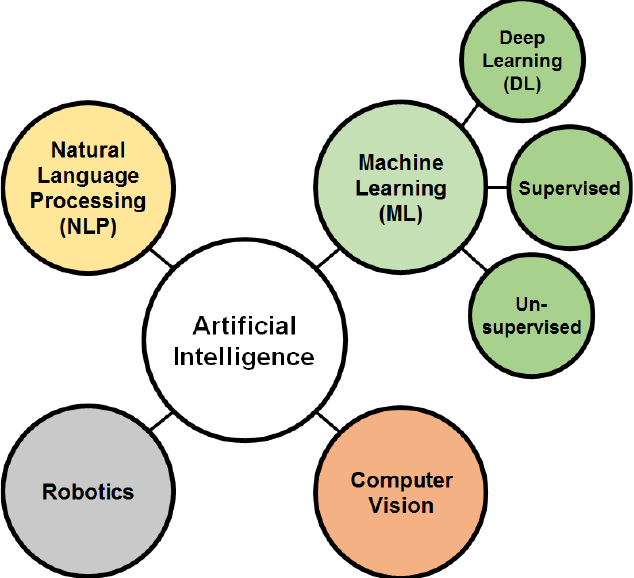
Figure 1. Artificial intelligence